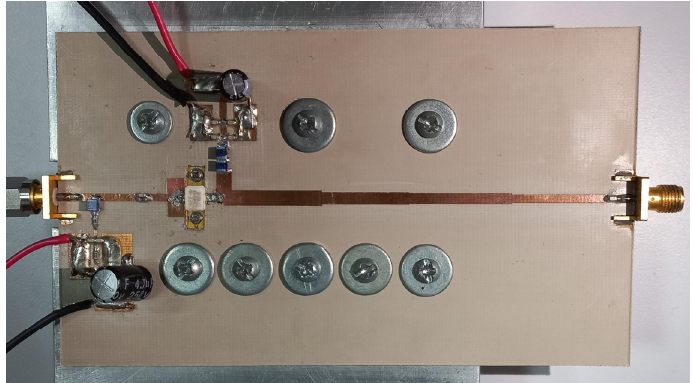
Figure 5. Picture of the designed PA. Size: 12.8 cm × 5 cm.